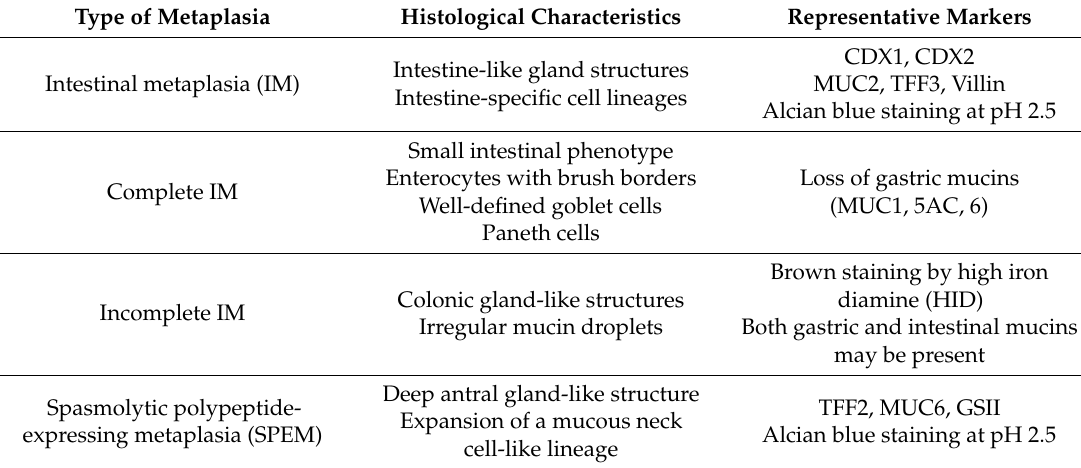
Table 1. Characteristics of metaplastic lesions in the human